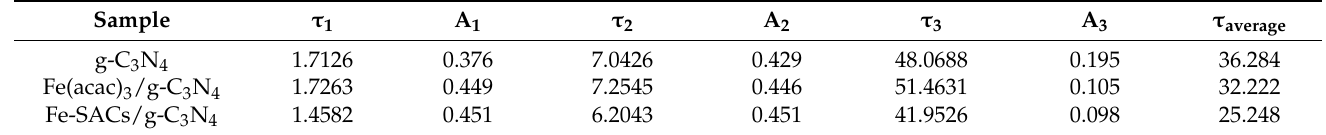
Table 1. Kinetic parameters of time-resolved florescence decays of g-C 3 N 4 , Fe(acac) 3 /g-C 3 N 4, and Fe-SACs/g-C 3 N 4 under 470 nm